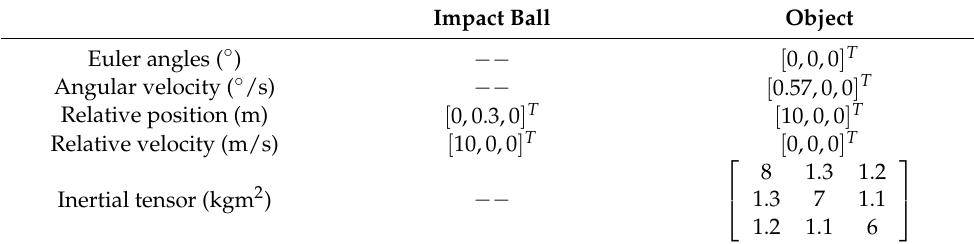
Table 1. Initial conditions and parameters of the impact ball and the object.